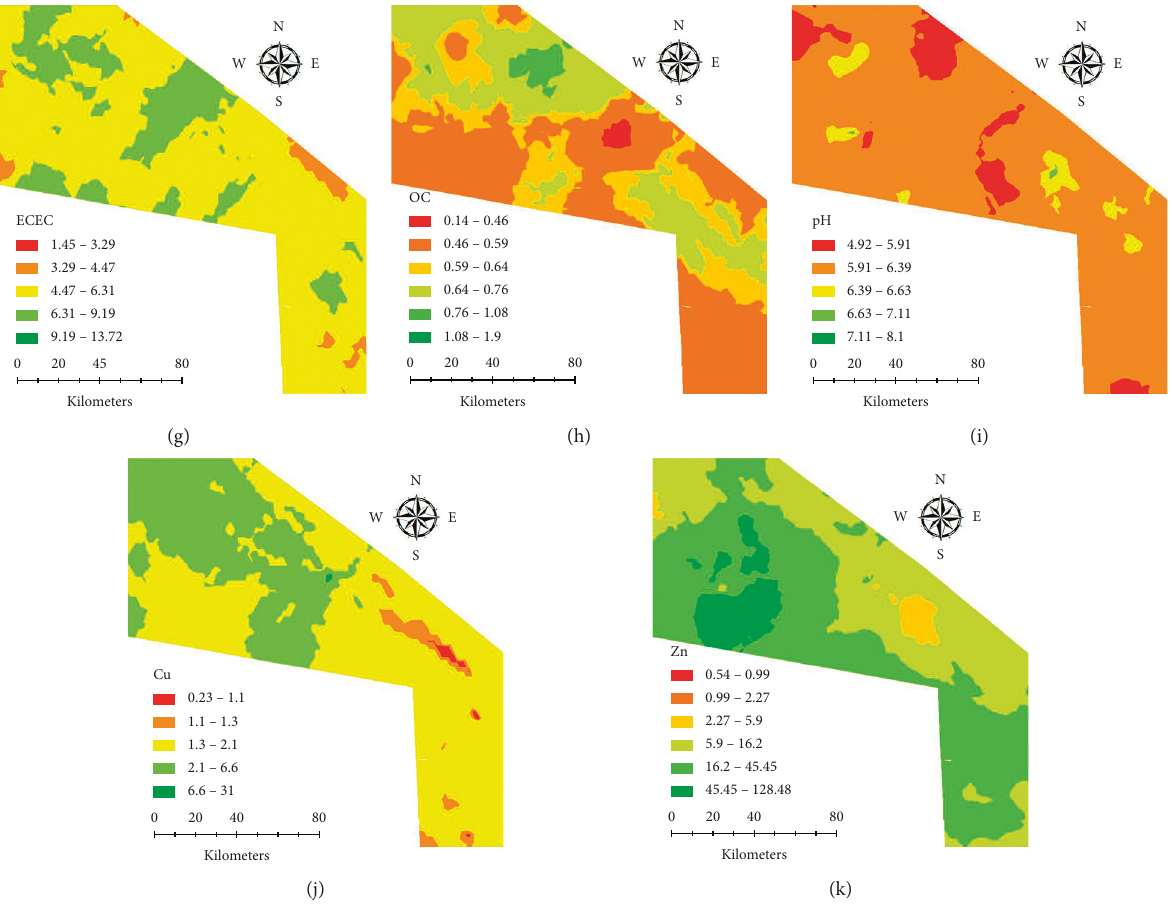
Figure 2: Spatial variability maps of soil properties: (a) sand (%), (b) silt (%), (c) clay (%), (d) total nitrogen (TN%), (e) available phosphorus (Av.P mg kg − 1 ), (f) exchangeable potassium (K cmol(+) kg − 1 ), (g) effective cation exchange capacity (ECEC cmol(+) kg − 1 ), (h) soil organic carbon (OC %), (i) potential hydrogen (pH), (j) copper (Cu), and (k) zinc